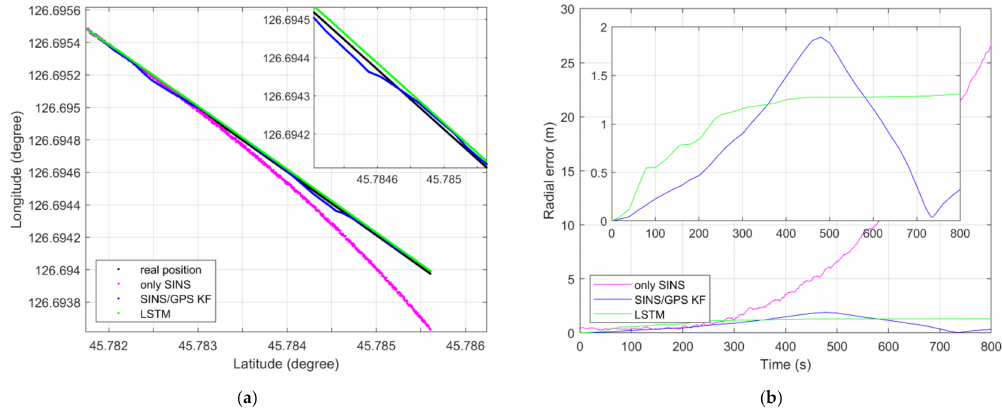
Figure 9. ( a ) Dynamic position estimation of experiment; ( b ) dynamic position radial error of